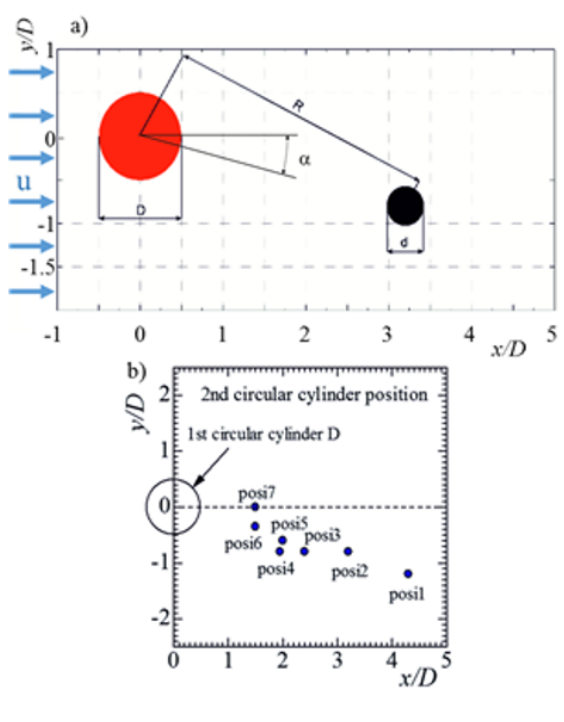
Fig. 1. Set-up of cylinders: a) coordinate system and notation , b) positions of